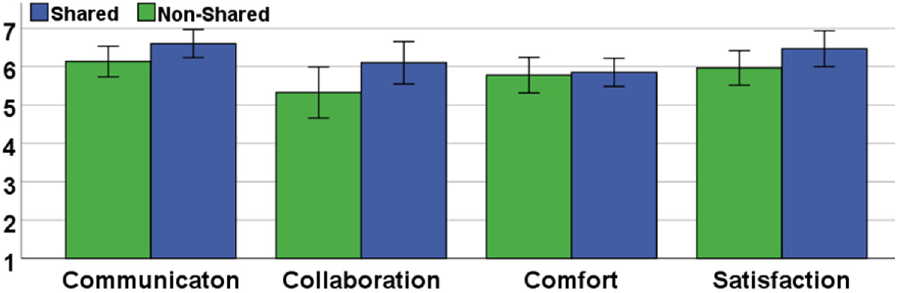
Figure 9. Mean ratings for the communication, collaboration, comfort, and satisfaction categories of the collaboration questionnaire. Error bar indicates ±2 standard errors.